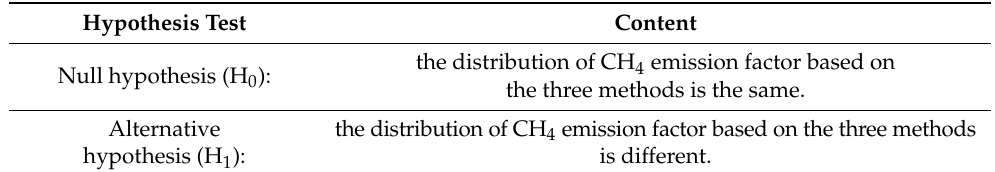
Table 8. Null hypothesis by CH 4 emission factor about sampling method.